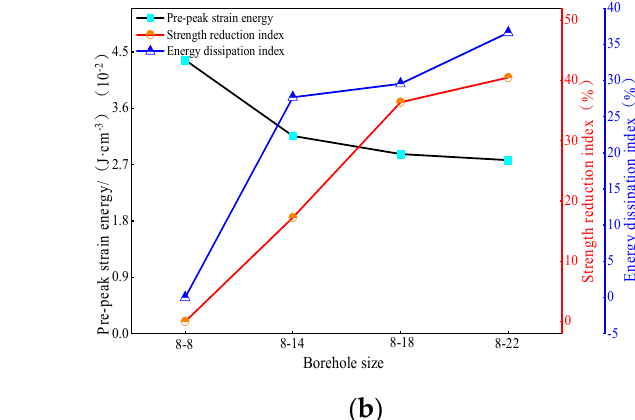
Table 2. Post − peak mechanical parameters of each sample under different borehole sizes.